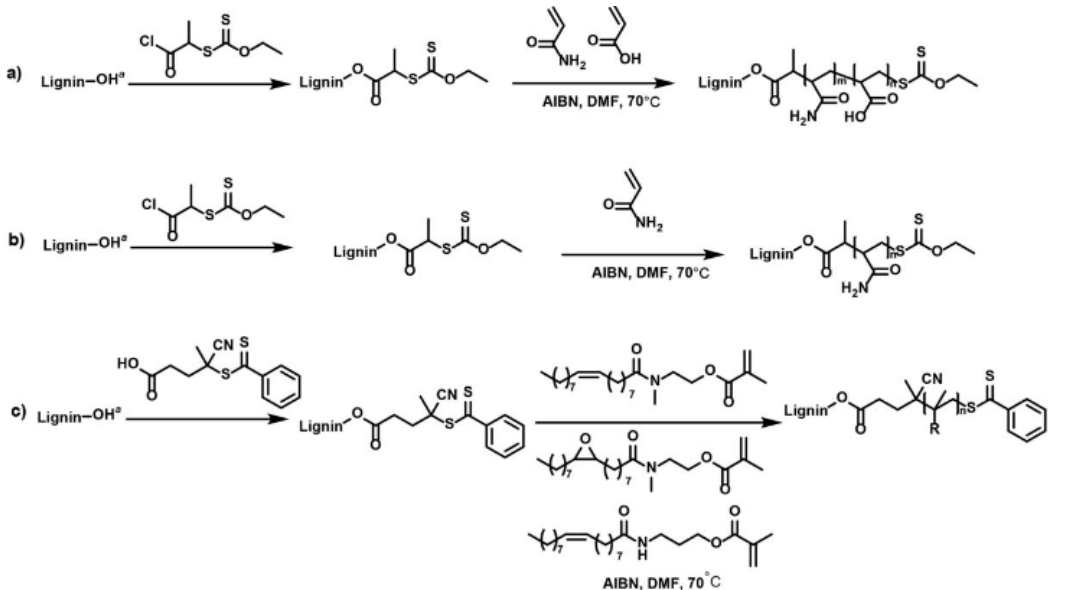
Figure 2. RAFT polymerization demonstrating: ( a ) acrylic acid and acrylamide graft-from polymerization; ( b ) RAFT polymerization of acrylamide; ( c ) soybean oil polymerization using the graft-from technique. The lignin compound is comprised of both phenolic hydroxyl and aliphatic hydroxyl groups [16].